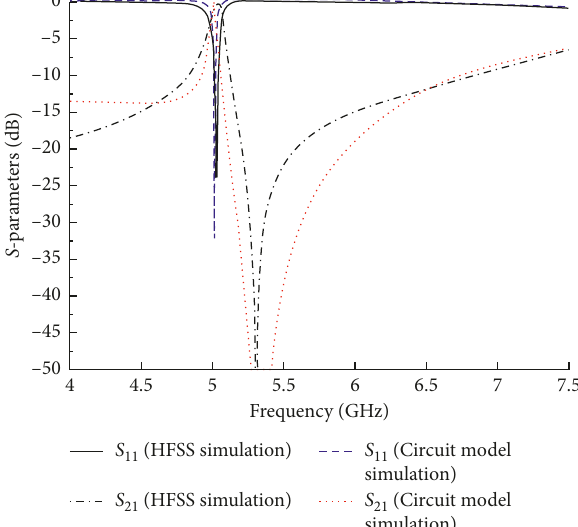
Figure 3: Simulated S -parameter responses corresponding to the unit cell shown in Figure 2(a). The geometrical parameters for the unit cells are w � 12.3mm, L � 2mm, g � 0.18mm, a 1 � 3.92mm, and a 2 � 3.92mm. The electrical parameters of the equivalent circuit models in this case are L d � 0.9 nH, L c � 0.6nH, C c � 0.5pF, L r � 1.15nH, and C r � 1pF [9].